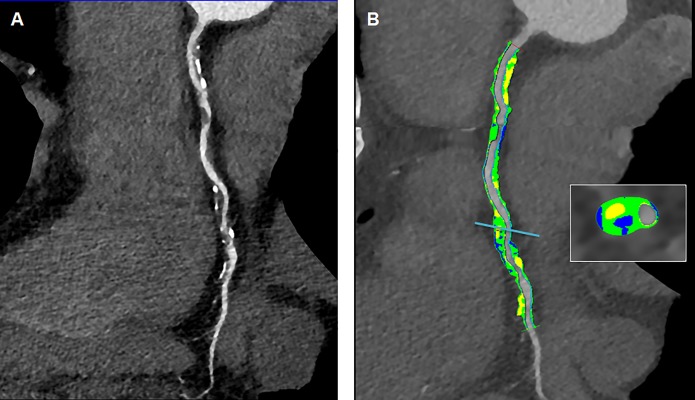
(A) Curved multi planar reconstruction of a right coronary artery showing a severe atherosclerosis with both calcified and non-calcified plaques. (B) Semi-automatic segmentation of coronary vessel: calcified component (yellow), lipid component (green) and fibrotic (blue).